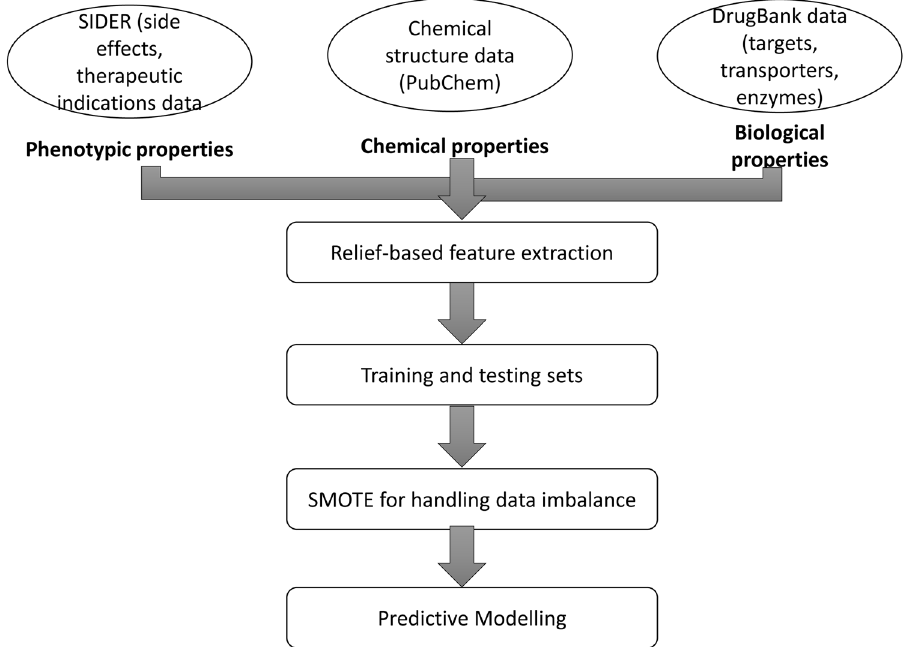
Figure 1. The computational methodology followed in the present study has been shown in Fig.